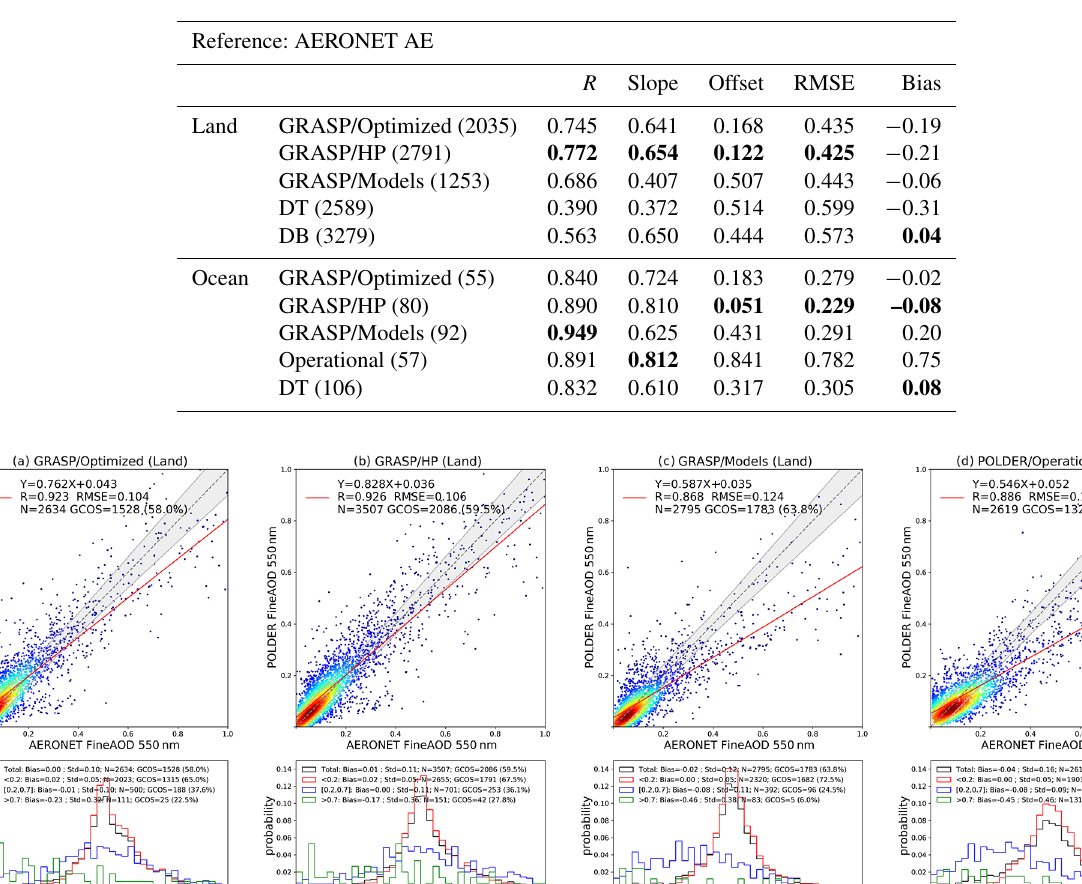
Table 11. Statistics of PARASOL and MODIS AE products against collocated AERONET AE over land and ocean, with a threshold of satellite AOD (550nm) > 0.2.